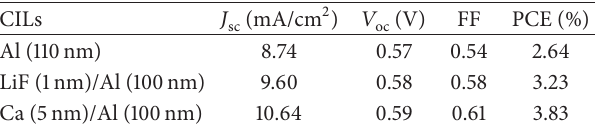
Figure 3: J-V characteristics of the devices with different anneal- ing temperatures, measured under 100mW/cm 2 illumination (AM 1.5G). The structure of the devices is ITO/PEDOT:PSS/ P3HT:PC 70 BM (200nm)/Al. Table 3: Photovoltaic parameters of the devices with different CILs, measured under 100 mW/cm 2 illumination (AM 1.5G). The struc- ture of the devices is ITO/PEDOT:PSS/P3HT:PC 70 BM (200 nm)/Al (with no thermal treatment).